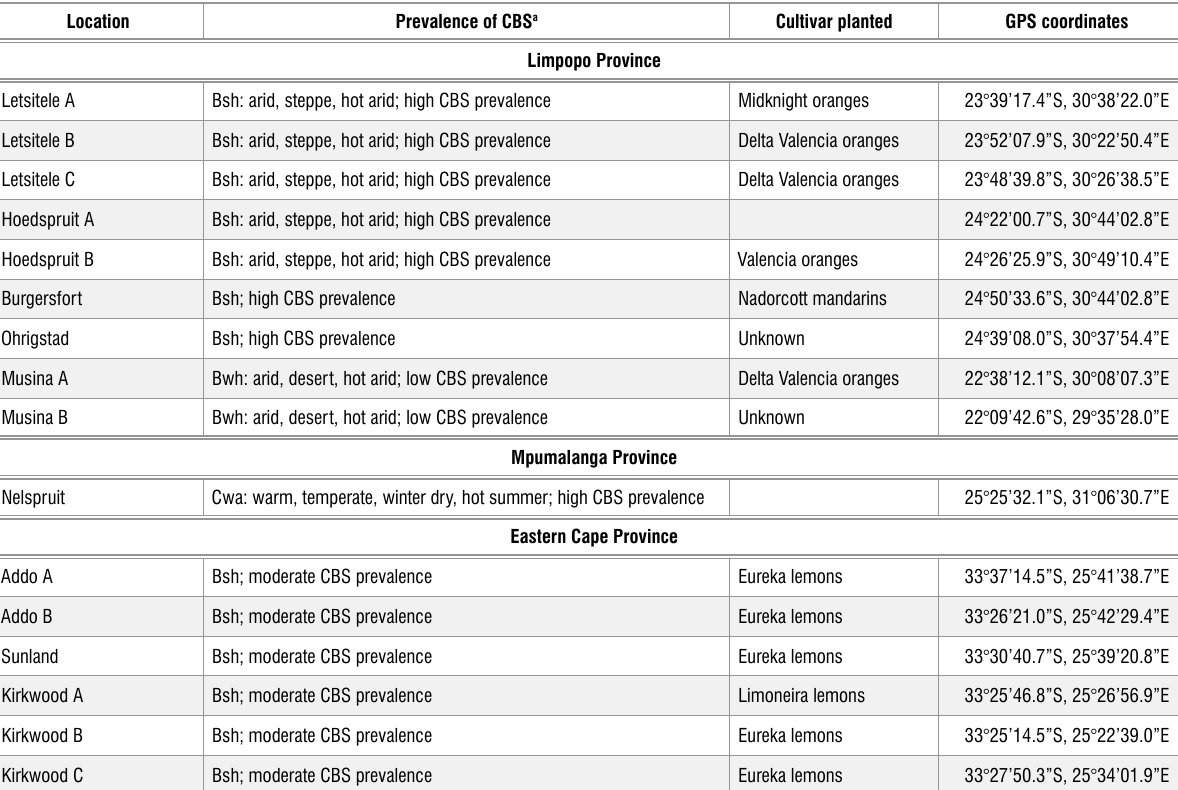
Table 1: Information on the study sites including location, cultivar planted and prevalence of citrus black spot (CBS) Location Prevalence of CBS a Cultivar planted GPS coordinates Limpopo